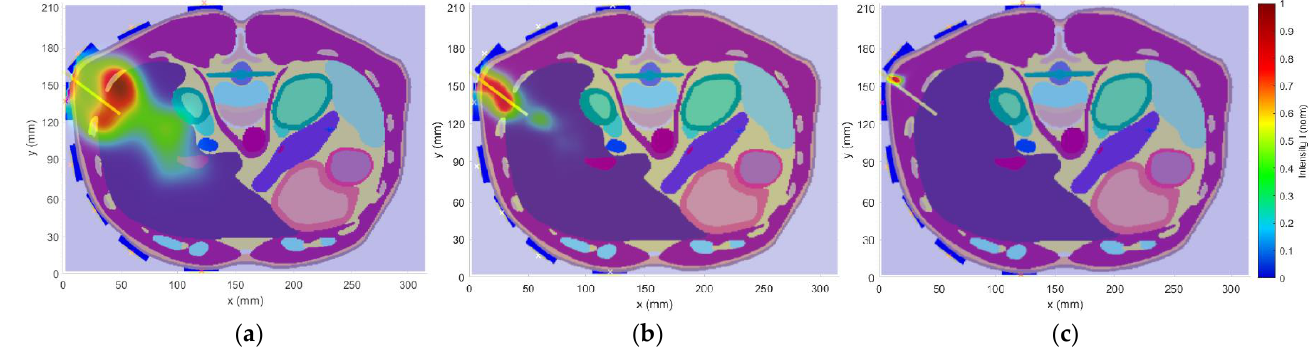
( b ) Figure 16. The antenna polarization study results: ( a ) Reconstruction for vertically placed antennas; ( b ) Reconstruction for horizontally placed antennas.